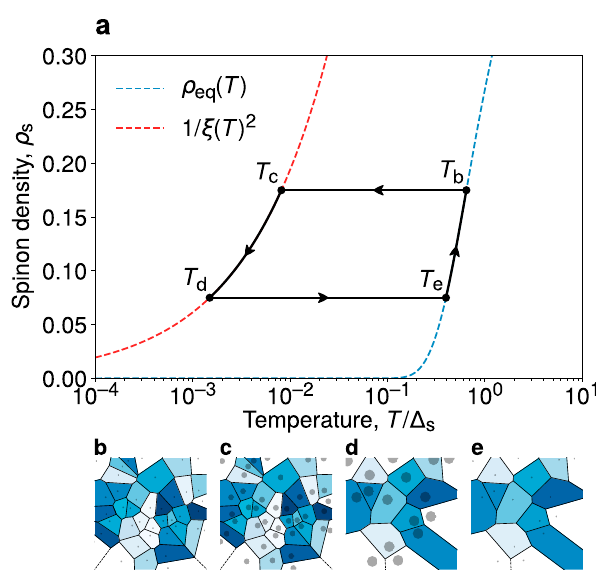
Fig. 4 Nonequilibrium response of the spinon density to a temperature cycle. a Schematic illustration of the nonequilibrium spinon density. The system is initially prepared in equilibrium at temperature T b . If temperature is then lowered at a suf fi ciently large rate, ρ s falls out of equilibrium — the patches grow in diameter but their diffusive motion is slow. At T c , the typical separation of the patches becomes comparable to their radius ξ , and the closest pairs begin to annihilate. The density then remains kinematically locked to 1/ ξ 2 as pairs continue to annihilate. If the direction of temperature variation is then reversed at T d , ρ s develops another plateau as pairwise annihilation of spinons ceases and the diameter of the patches shrinks. This continues until a suf fi ciently high temperature, T e , is reached at which thermodynamic equilibrium is restored. The behaviour of the vison- depleted patches at each of these temperatures is depicted in b – e . The patches are qualitatively represented by the solid circles and identi fi ed by the colour of their Voronoi